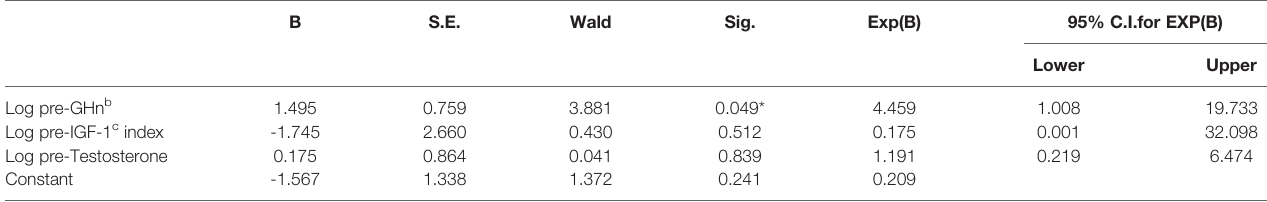
TABLE 3 | Multivariate analysis between ED a and non-ED patients in the baseline. B S.E. Wald